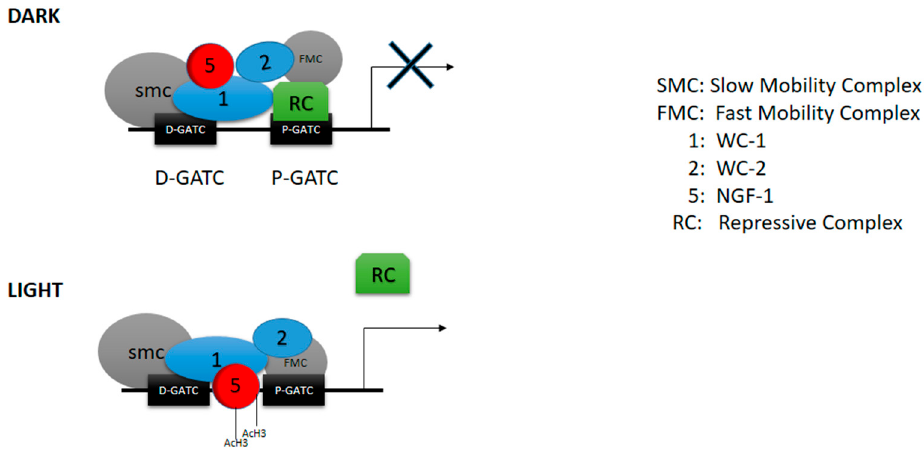
Figure 5. Proposed molecular model. Schematic representation that summarizes the data discussed in the paper. White collar complex (WCC), slow mobility complex, and fast mobility complex form a preassembled molecular scaffold, present already in the dark. Moreover, the WCC binds the acetyltransferase NGF-1. The presence of a putative repressive complex is suggested even if it is not clear what proteins are involved. After light pulse, the WC-2:FMC complex binds the promoter, and the repression is abolished. The acetyl transferase NGF-1 is placed onto the promoter in order to modify the light-dependent chromatin acetylation, and gene expression is promoted.